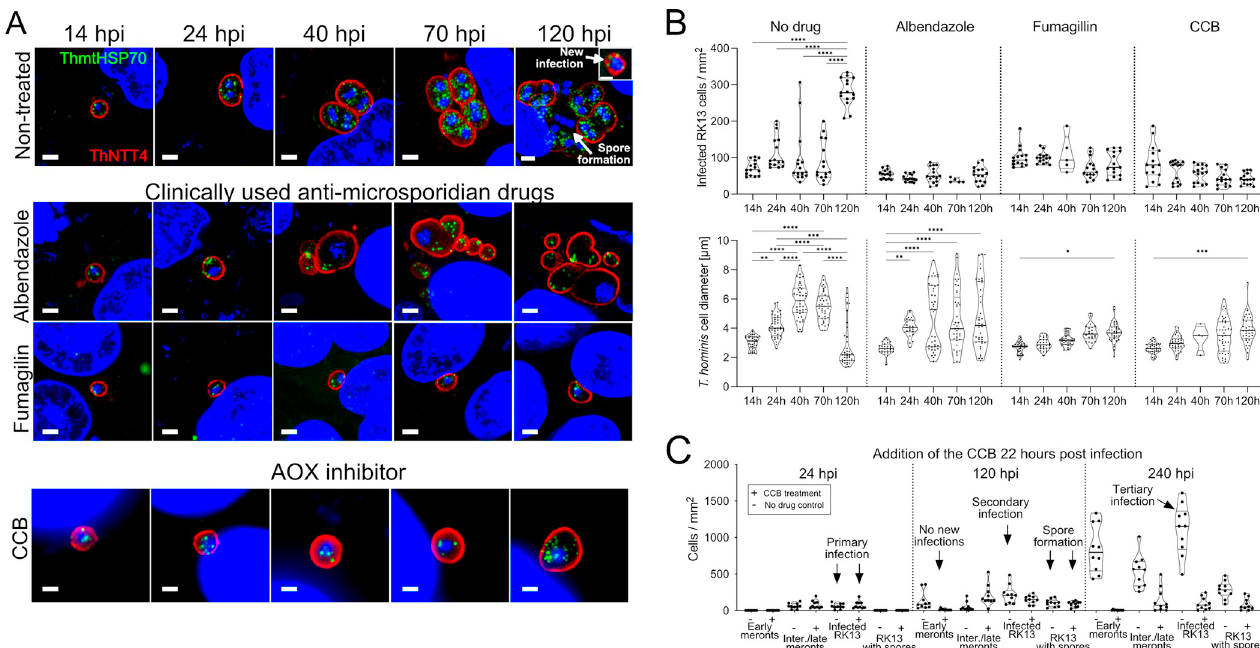
Fig 3. AOX inhibitor supresses growth of T . hominis cells inside the RK13 host cells at early meront stages of the infection, and affects the ability to infect by the spores formed in the presence of the drugs. Effects of the two clinically used anti-microsporidian drugs (albendazole, 350 nM; and fumagillin, 200 nM), and an inhibitor of the AOX Colletochlorin B (CCB, 50 μ M) on progression of the parasite life cycle were tested in a synchronised time course of infection in T . hominis- RK13 infection system. The drugs were added to infective spores suspended in culture medium 24 hours prior to the initiation of infection. (A) Confocal immunofluorescence images of representative T . hominis cells labelled with rabbit antibodies against ThNTT4 (red) and rat antibodies against mtHSP70 (green); observed in samples collected at different time points of incubation with the drugs. The time points corresponded to: observed decreased number of the mitosomes labelled with anti-AOX/mtG3PDH antibodies (14h), first nuclear division (24h), first cellular division (40h), initiation of the spore formation (70h), infection of new host cells by newly formed mature spores (120h). New infections were first observed at 96h (Fig 2C); but dominated cultures and were quantified at 120 hours post infection. Nuclei of the parasite and the host were labelled with DAPI (blue), scale bars correspond to 2 μ m (non-treated, albendazole, fumagillin) or 1 μ m (CCB). (B) Violin plots of the numbers of the T . hominis infected RK cells (top row), or the diameter of T . hominis cells (bottom row) observed across a time course of infection in presence of the drugs (albendazole, fumagillin, and CCB), and in the non-treated control (No drug). Datapoints were displayed as black circles. ANOVA analysis was used to test significance of the differences between the measured values ( ���� , P � 0.0001; ��� , P � 0.001; �� , P � 0.01; � , P � 0.05). The same no drug control was used for comparisons with the different treatment groups (S6 Fig). All experiments were performed in three biological replicates. (C) To test the effects of the CCB on the parasite development after the observed loss of the AOX and mtG3PDH mitosomal fluorescent signals (Figs 1D and 1F and S5) the drug was added 22 hours after the initiation of the infection (S8 Fig). Violin plots represent the numbers of the: T . hominis- infected RK13 cells (infected RK13), the RK13 cells containing bags of T . hominis spores (RK13 with spores), early T . hominis meronts (early meronts), and intermediate/late T . homnis meronts (inter./late meronts); observed across the time course of infection in the CCB- treated samples (+), or in the non-treated control